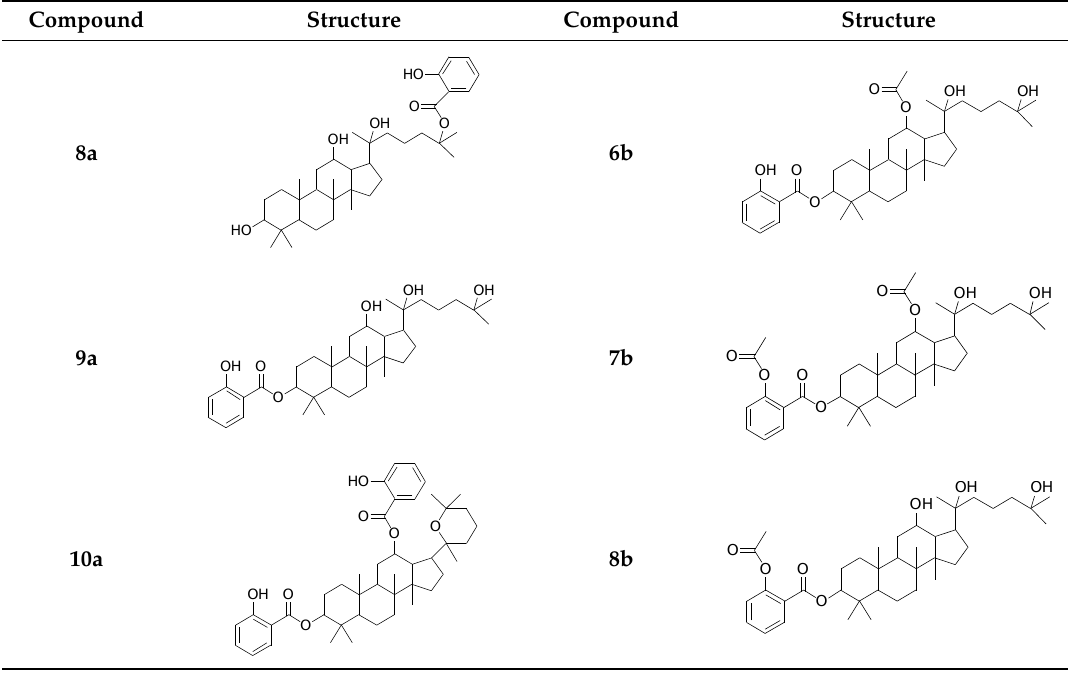
Table 2. Antitumor activity and cytotoxicity of ginsenoside derivatives (IC 50 , μM). Compound